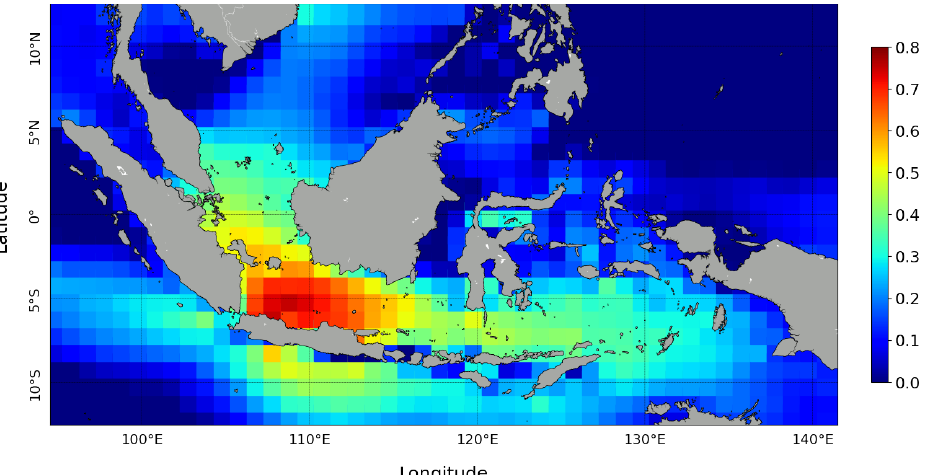
Figure 10. Spatial Correlation (SC) between wind speed data with significant wave height at the observation point in Jakarta